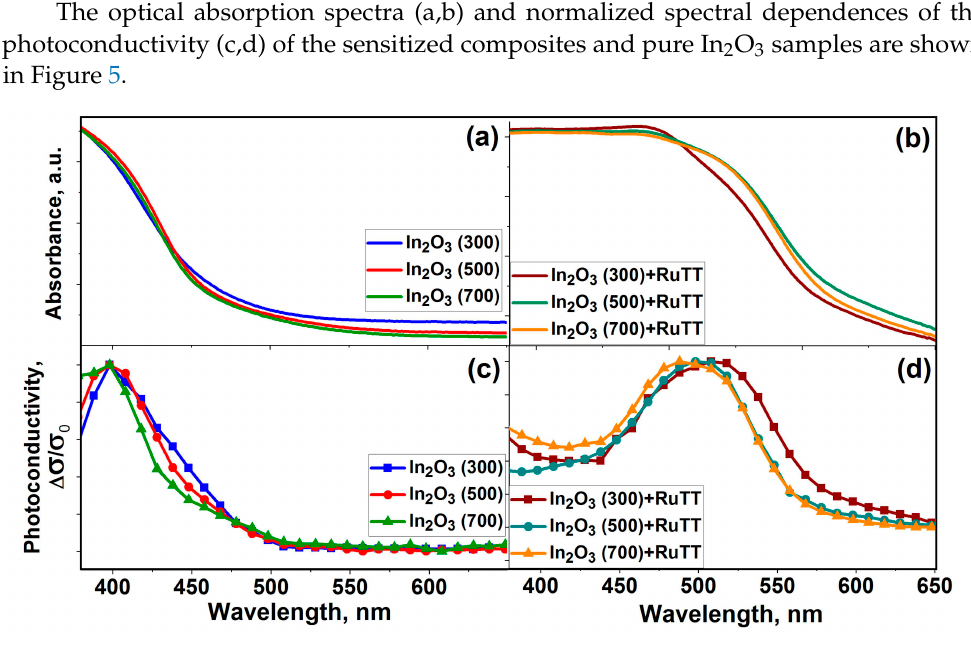
Figure 5. Optical absorption spectra ( a , b ) and normalized spectral dependences of the photoconduc- tivity ( c , d ) of pure semiconductors and hybrid